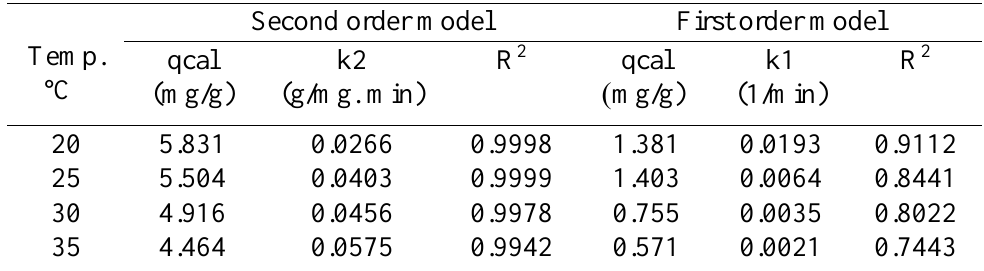
Fig. 14. intrapartical diffusion kinetic modal for methyl orange for concentration range (50−200 ppm) at 20 °C. Table 1. Average value of kinetic parameter of the adsorption Process in methyl orange at temperatures (20, 25, 30, 35)